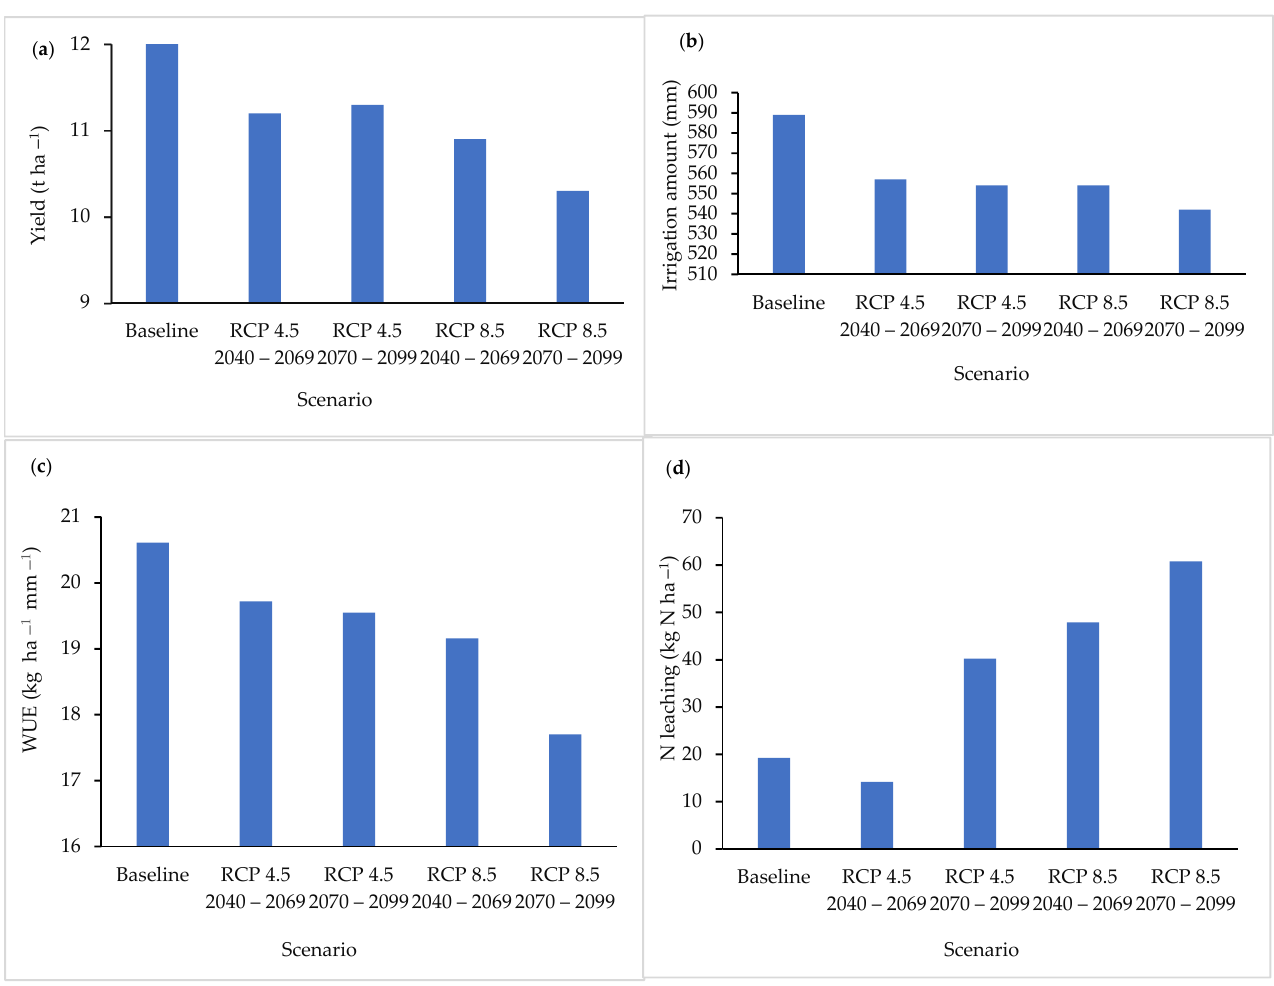
Figure 5. EPIC model outputs from the simulations using BCC-ESM climate data. Values are plotted and shown for the two 30-year periods compared to the baseline simulation; ( a ) yield, ( b ) seasonal irrigation, ( c ) water use efficiency (WUE), ( d ) N leaching.